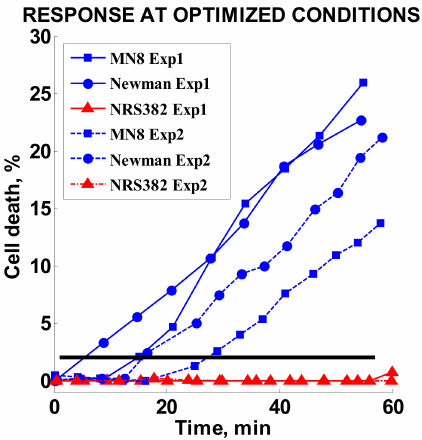
Figure 7. Cell death responses for two independent experiments using optimized conditions. Solid lines denote the first experiment (Exp1) and dashed lines show the second experiment (Exp2). The black horizontal line represents the 2% cell death threshold. Blue symbols were used for MSSA strains and red symbols show minimal death of MRSA